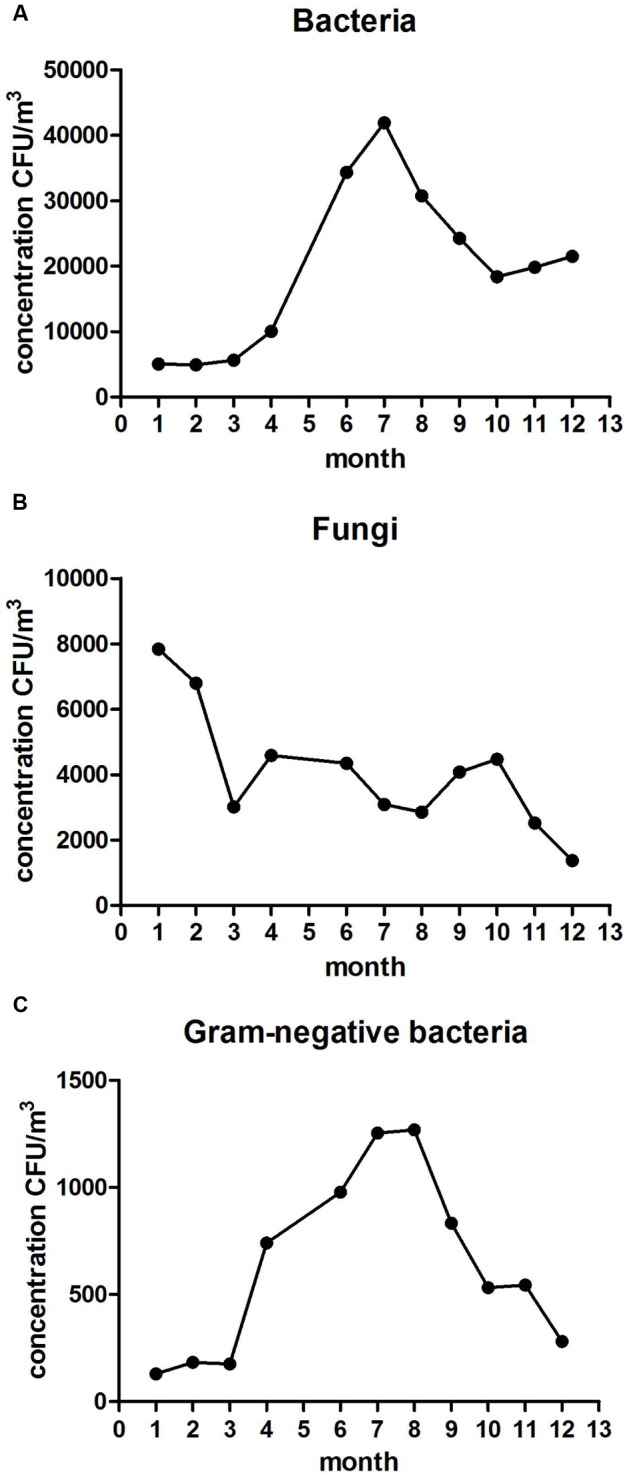
Average monthly concentration variations of bacteria (A), fungi (B), and Gram-negative bacteria (C).